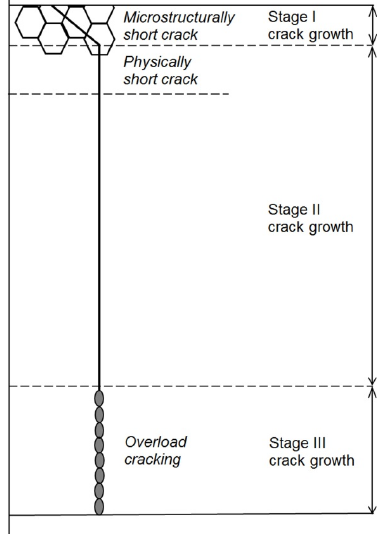
Figure 11. Schematic representation of fatigue crack development.